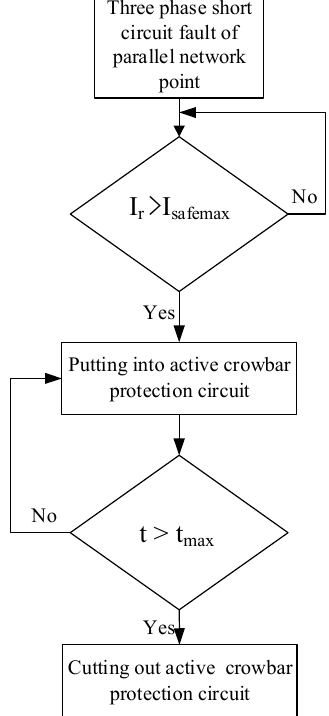
Figure 5. Control flow chart of active crowbar protection. During the fault period, when the transient process is basically finished, if the oper- ation of the rotor side converter can be restored in time, not only can the active power be balanced in time, but also the grid voltage will be strongly supported and improve the stability of the power system. If the recovery time of the rotor side converter overlaps or lags behind the recovery time of the grid voltage, the transient process of the power grid may be aggravated, and the risk of the secondary operation of the crowbar protection circuit exists.